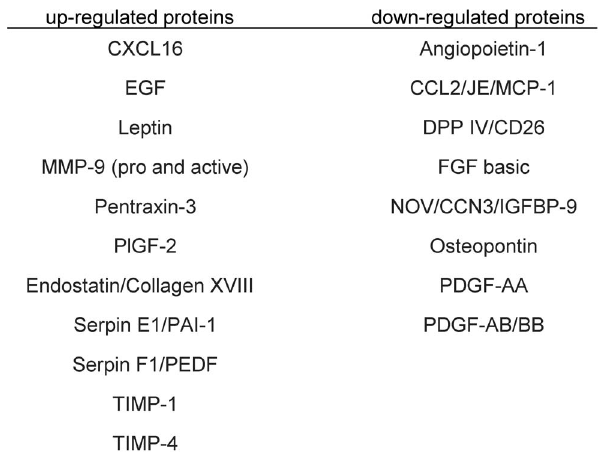
Figure 8. Protein array analysis of serum from common bile duct ligated (CBDL) and sham operated mice. Representative list of up-regulated and down-regulated proteins in the serum of common bile duct ligated mice, in comparison with the levels measured in sham operated mice by using protein array analysis. CXCL16, chemokine (CXC motif ligand 16); DLL4, delta-like ligand 4; DPPIV, dipeptidyl peptidase IV; EGF, epidermal growth factor; MMP-9, matrix metallopeptidase 9; FGF, fibroblast growth factor; MCP-1, monocyte chemotactic protein-1; TIMP-1, tissue inhibitor of metalloproteinase-1; CCL2/JE/MCP-1, chemo- kine (CC motif) ligand 2; NOV/CCN3/IGFBP-9, nephroblastoma overex- pressed; VEGF, vascular endothelial growth factor; PDGF, platelet- derived growth factor.